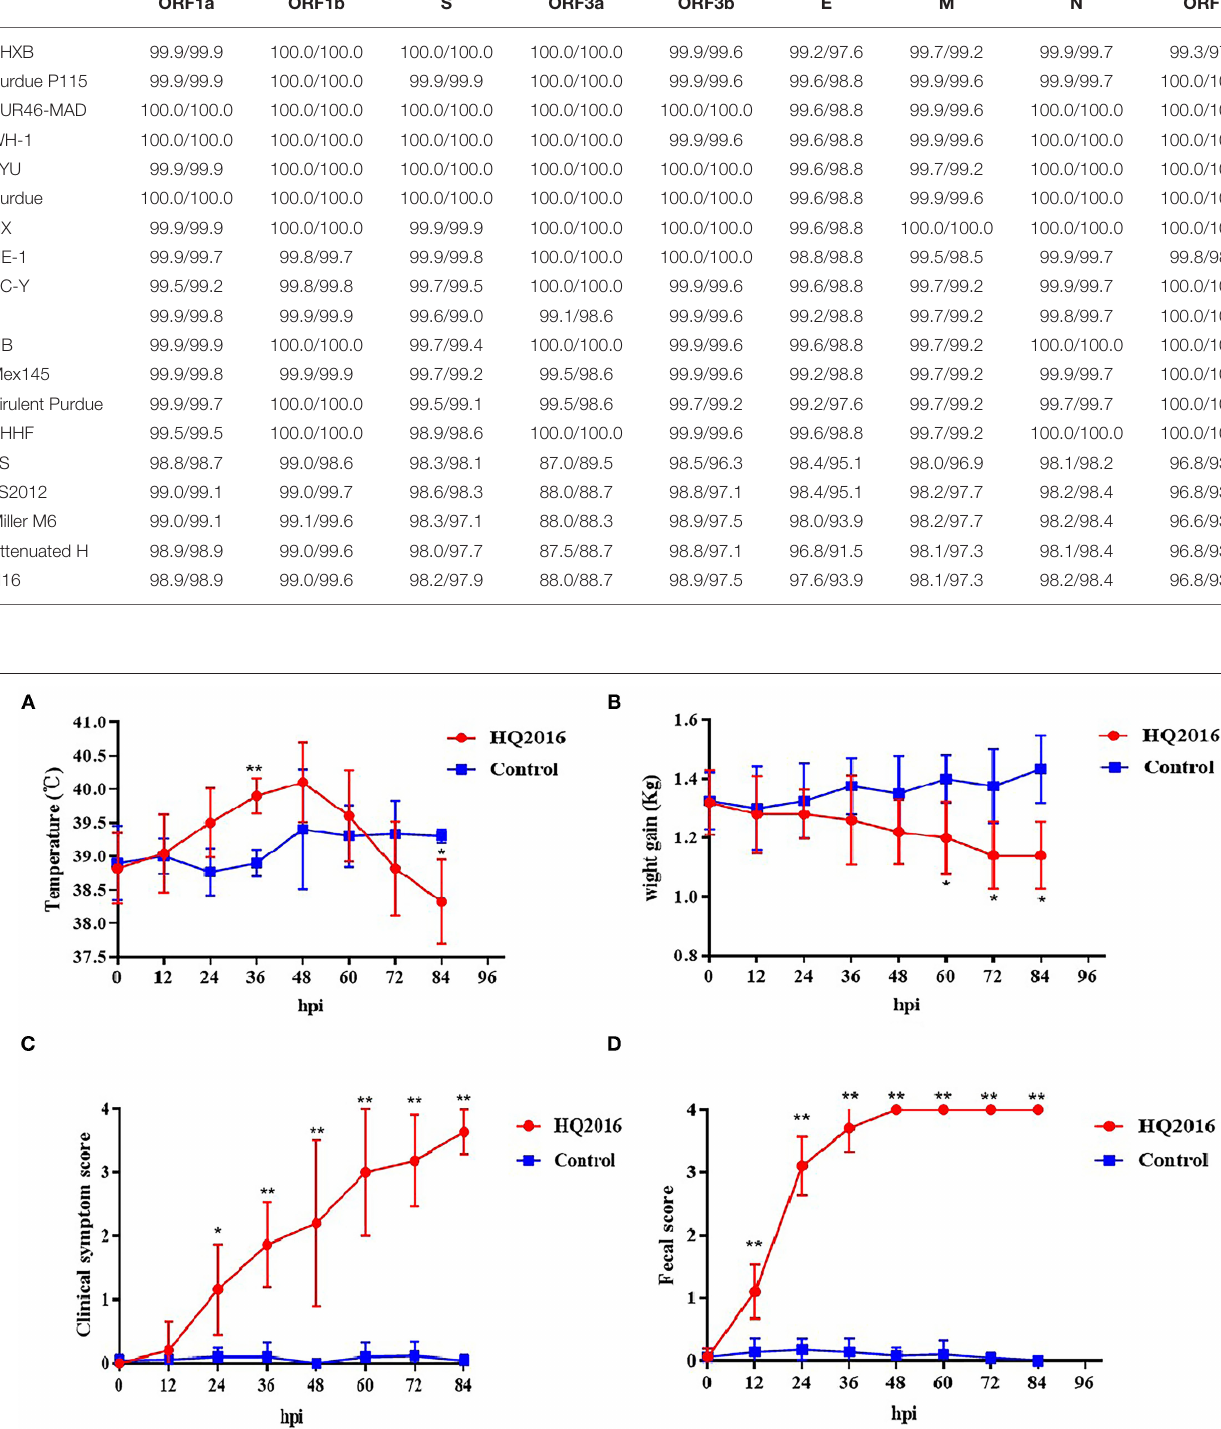
Frontiers in Veterinary Science |